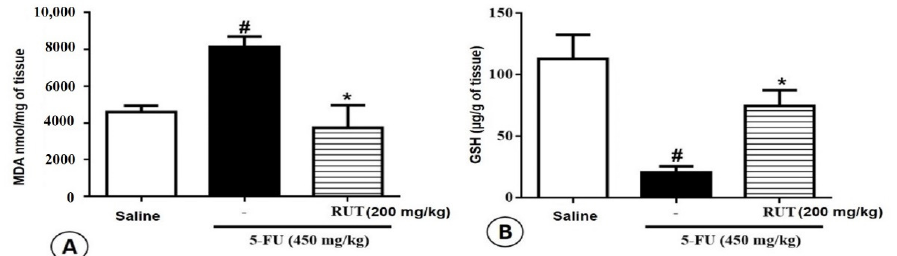
Figure 8. Analysis of oxidative stress. ( A ) Malondialdehyde (MDA), ( B ) Glutathione (GSH). Experimental groups: Saline, 5-FU, and RUT 200 mg / kg. Values are presented as mean ± SEM. For the statistical analyses, one-way analysis of variance was used, followed by Tukey’s test. # p < 0.05 vs. saline group and * p < 0.05 vs. group 5-FU. 5-FU, 5-fluorouracil; RUT, rutin .